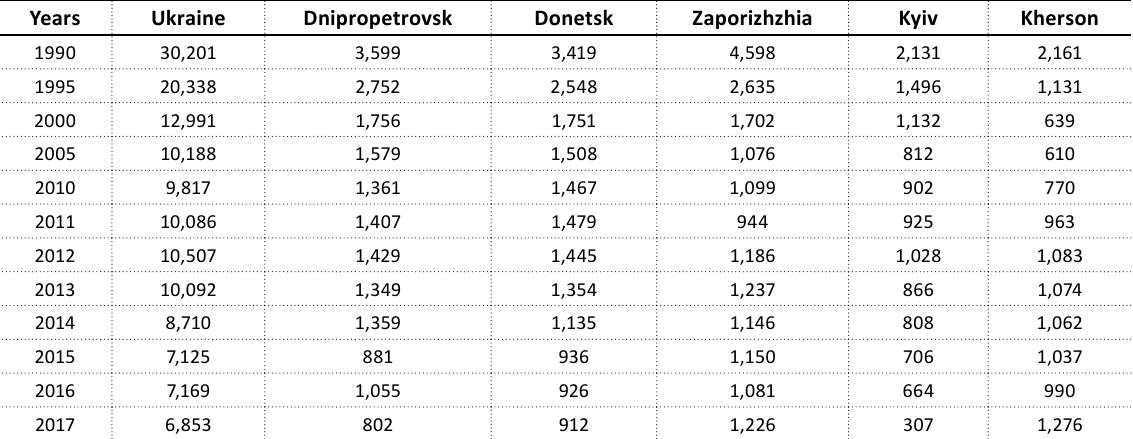
Table 1. Use of fresh water by regions of Ukraine, including freshwater and seawater, million m 3 Source: Created according to the State Statistics Service of Ukraine